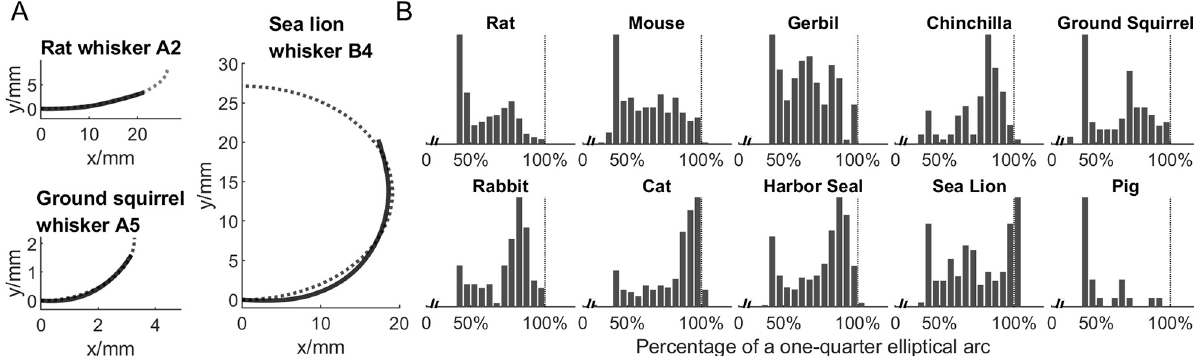
Fig 5. Results of fitting whiskers to an elliptical model are shown. (A) Three exemplar whiskers fit to ellipses are shown. Solid curve: Whisker. Dotted curve: Fit elliptical arc. (B) For each species, the histogram shows the number of whiskers that occupy a given percentage of a ¼ elliptical arc. Values greater than 100% (vertical dotted lines) indicate that the whisker occupied more than ¼ of the elliptical arc. The histogram bin value adds up to the total number of whiskers shown in Table 1.